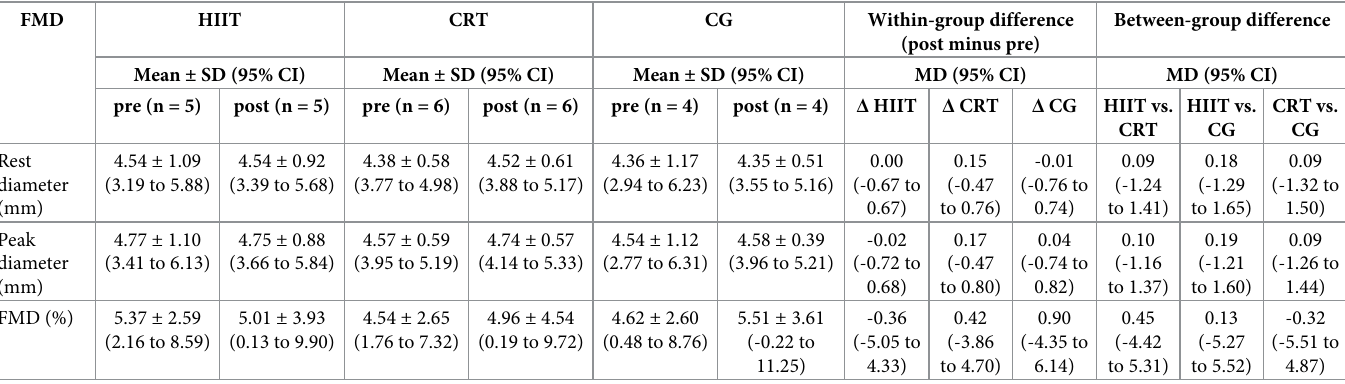
Values are expressed as mean ± standard deviation (SD), mean difference (MD) and 95% CI (confidence interval). Comparisons between groups were analyzed by the mixed ANOVA with Bonferroni post-test (within and between) for all parameters. � p � 0.05. HIIT, high-intensity interval training; CRT, circuit-resistance training; CG, control group; FMD, flow-mediated dilatation; mm, millimeter; Δ , post—pre